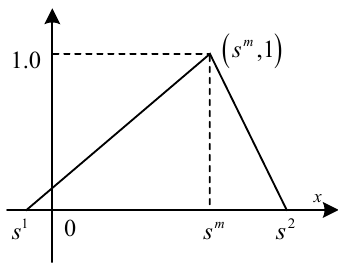
Figure 4. Triangular fuzzy